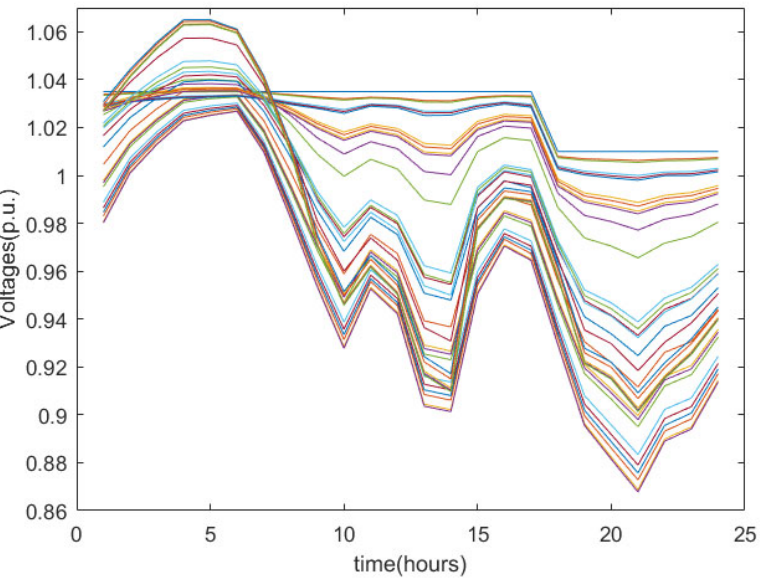
Figure 16. Node voltages (optimization level 2).